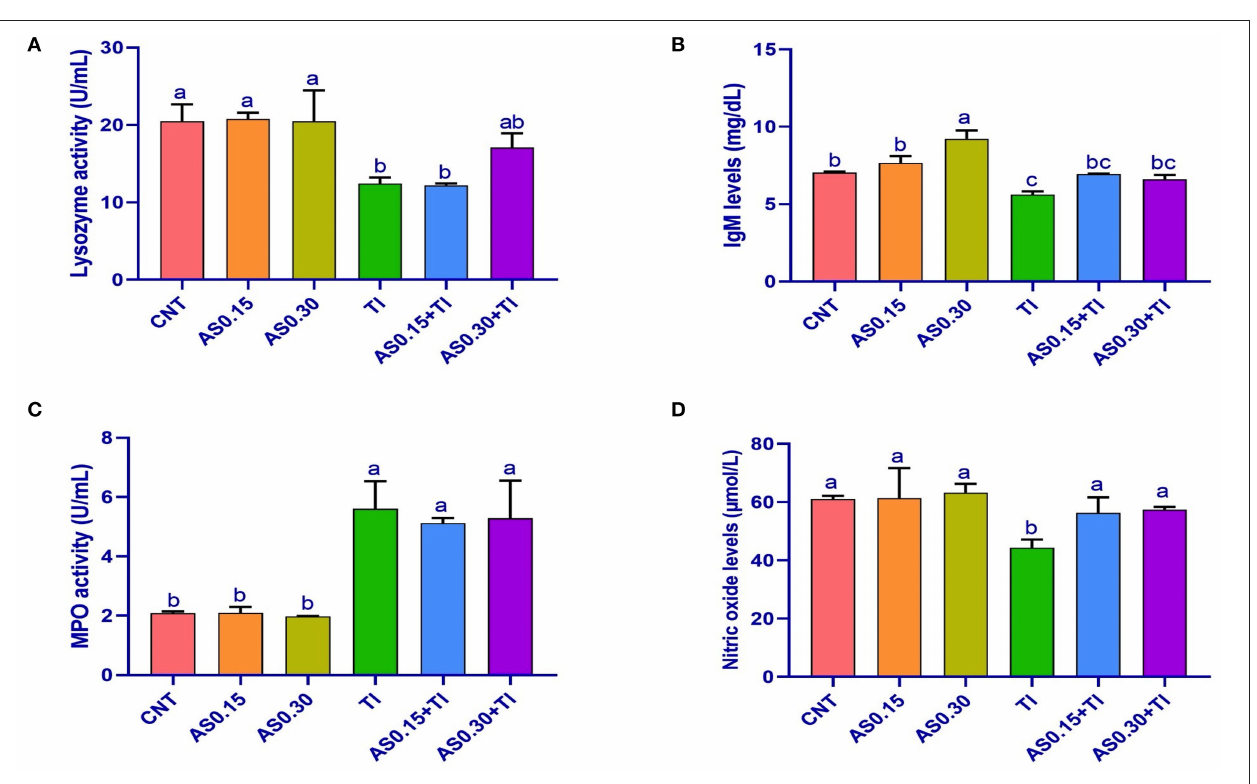
as it was completely recovered to attain the normal CNT range. As well, the expression of the IFN- γ gene was not mitigated in the AS0.15 + Tl group, while modulated only in the AS0.30 + Tl group, but did not attain the normal CNT range ( Figure 2